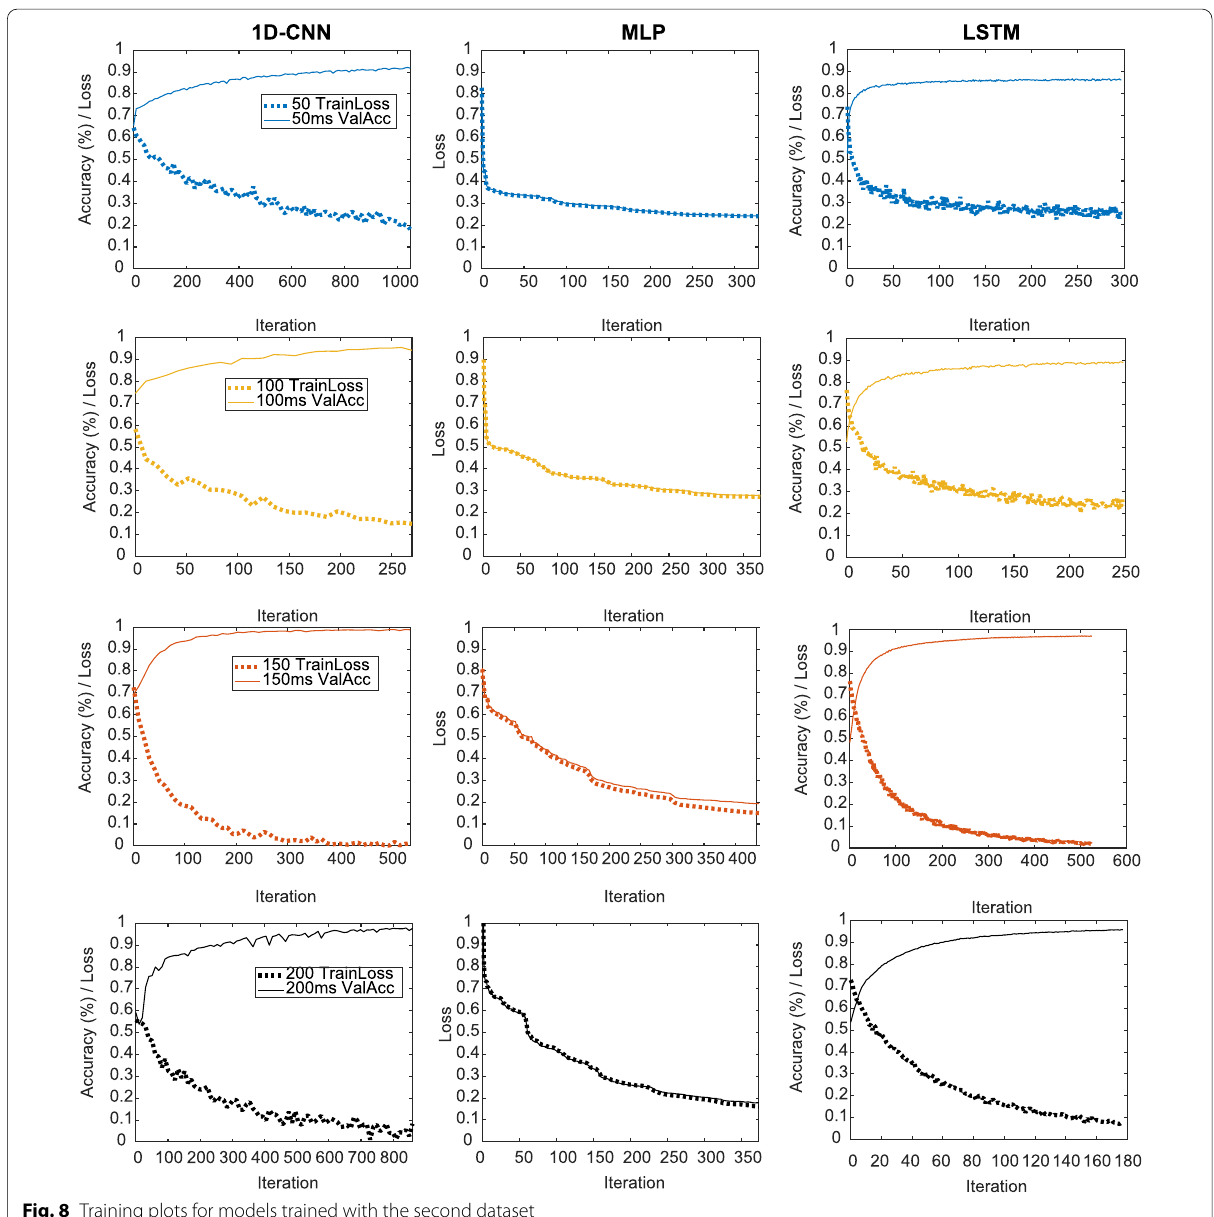
Fig. 8 Training plots for models trained with the second